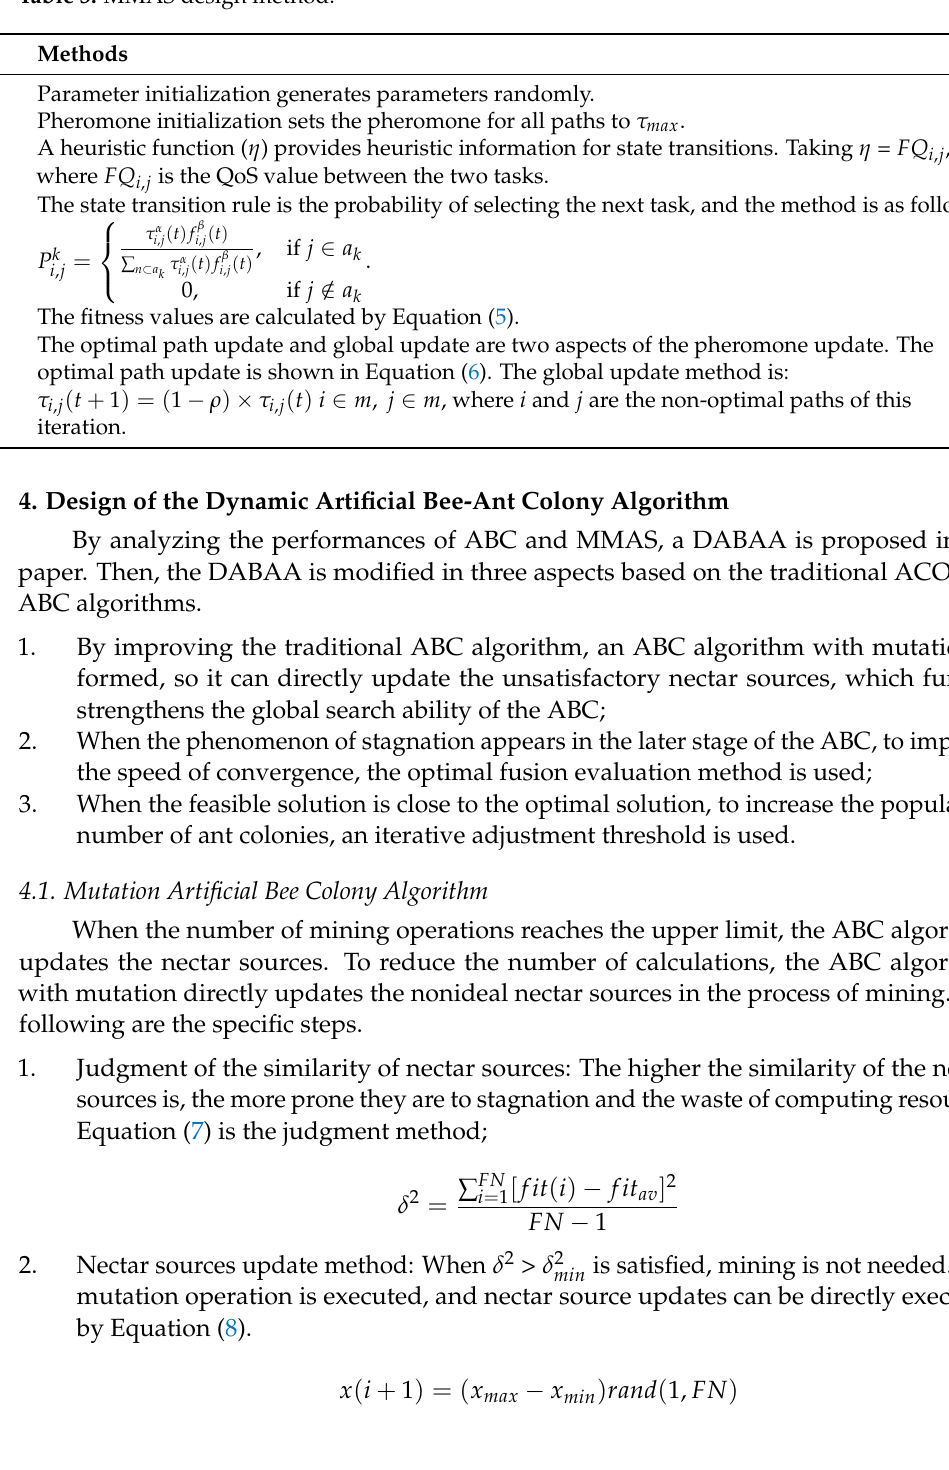
Table 3. MMAS design